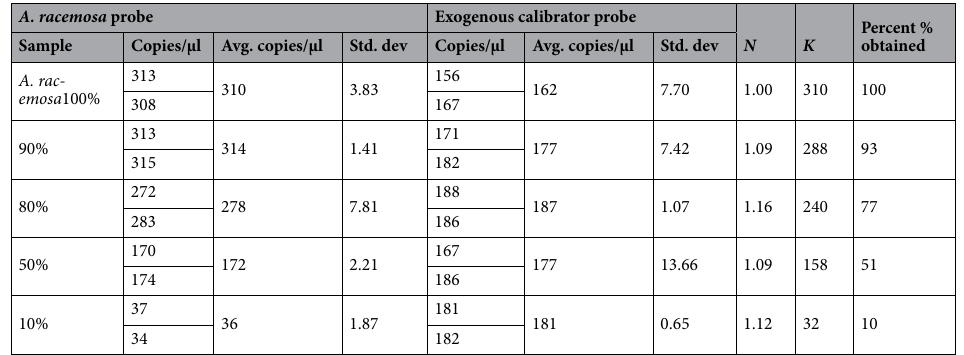
Table 1. Evaluation of the ratio of A. racemosa present in the engineered DNA mixture using dPCR. Standard deviations (Std. dev) for the A. racemosa assay and the exogenous calibrator assay are shown. Columns N represents normalised value and K represents normalised copy numbers of the